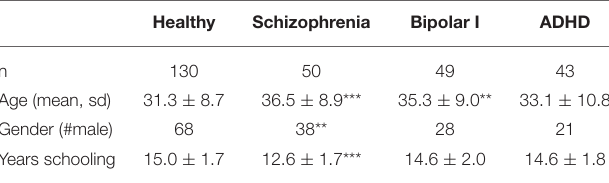
TABLE 1 | Demographic characteristics of the UCLA Phenomics